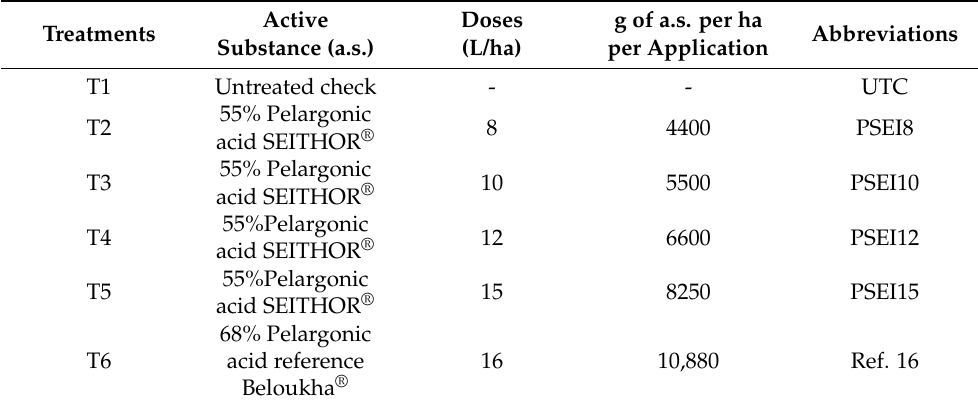
Table 5. Treatments applied on field trials. Treatments